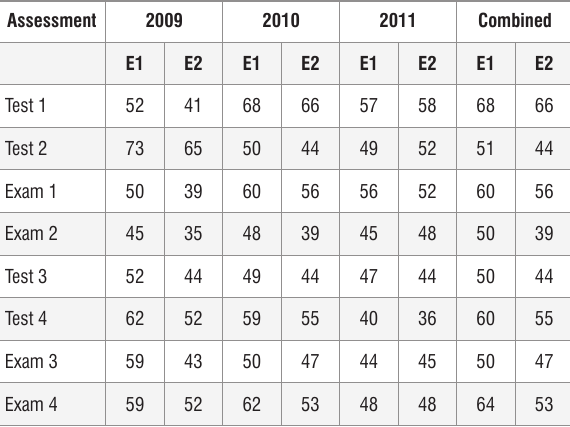
Assessment averages (%) for first- and second-language